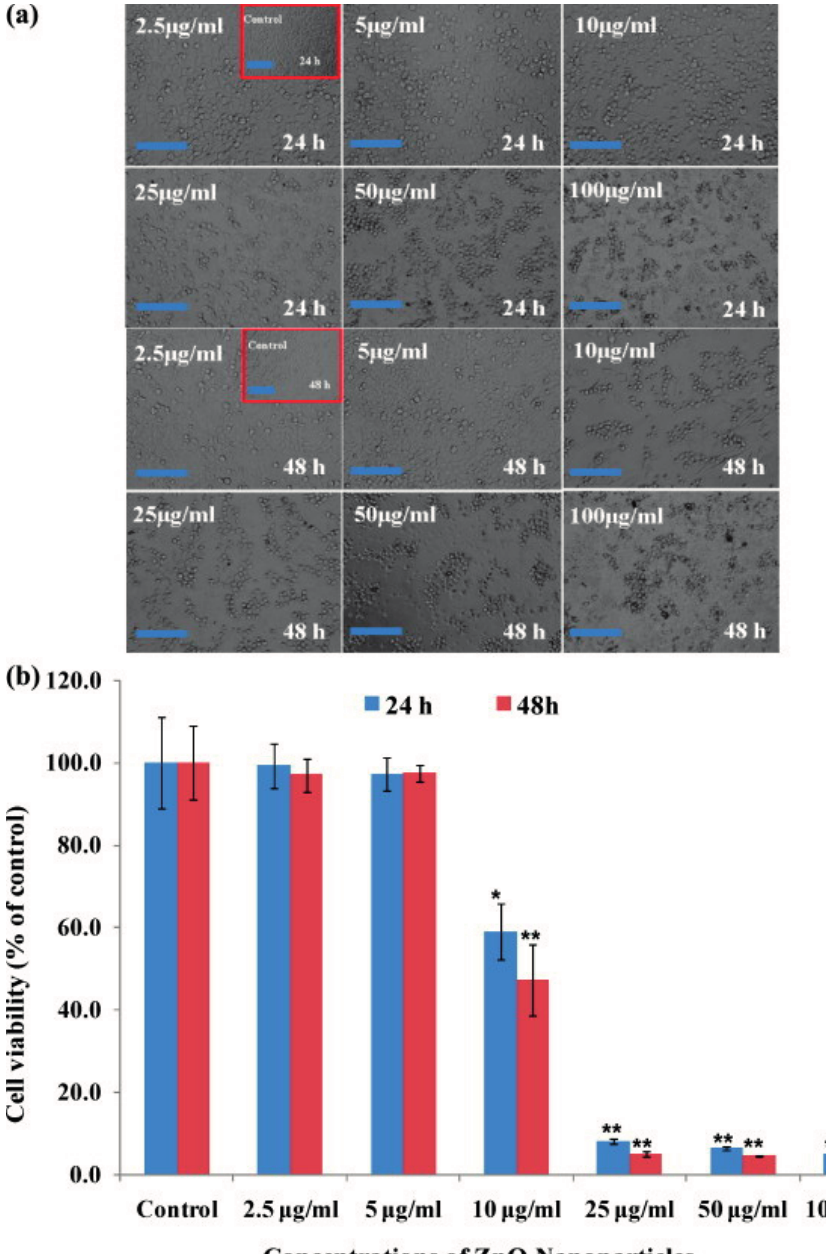
Figure 2. Microscopic images of HepG2 cells after treatment with ZnO NPs and the mitochondrial activity of cells exposed to various concentration of ZnO NPs for 24 and 48 h. The values are the mean ± SD of three independent experiments. * p < 0.01 and ** p < 0.001 vs. the control group (each scale bar = 1 mm). Reproduced with permission from [38]. Copyright 2014,